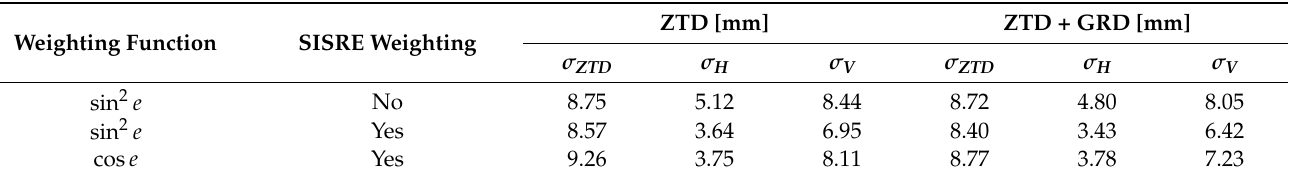
Table 2. The STD of the estimated ZTD ( σ ZTD ), repeatability of horizontal ( σ H ) and vertical ( σ V ) coordinates using different schemes.